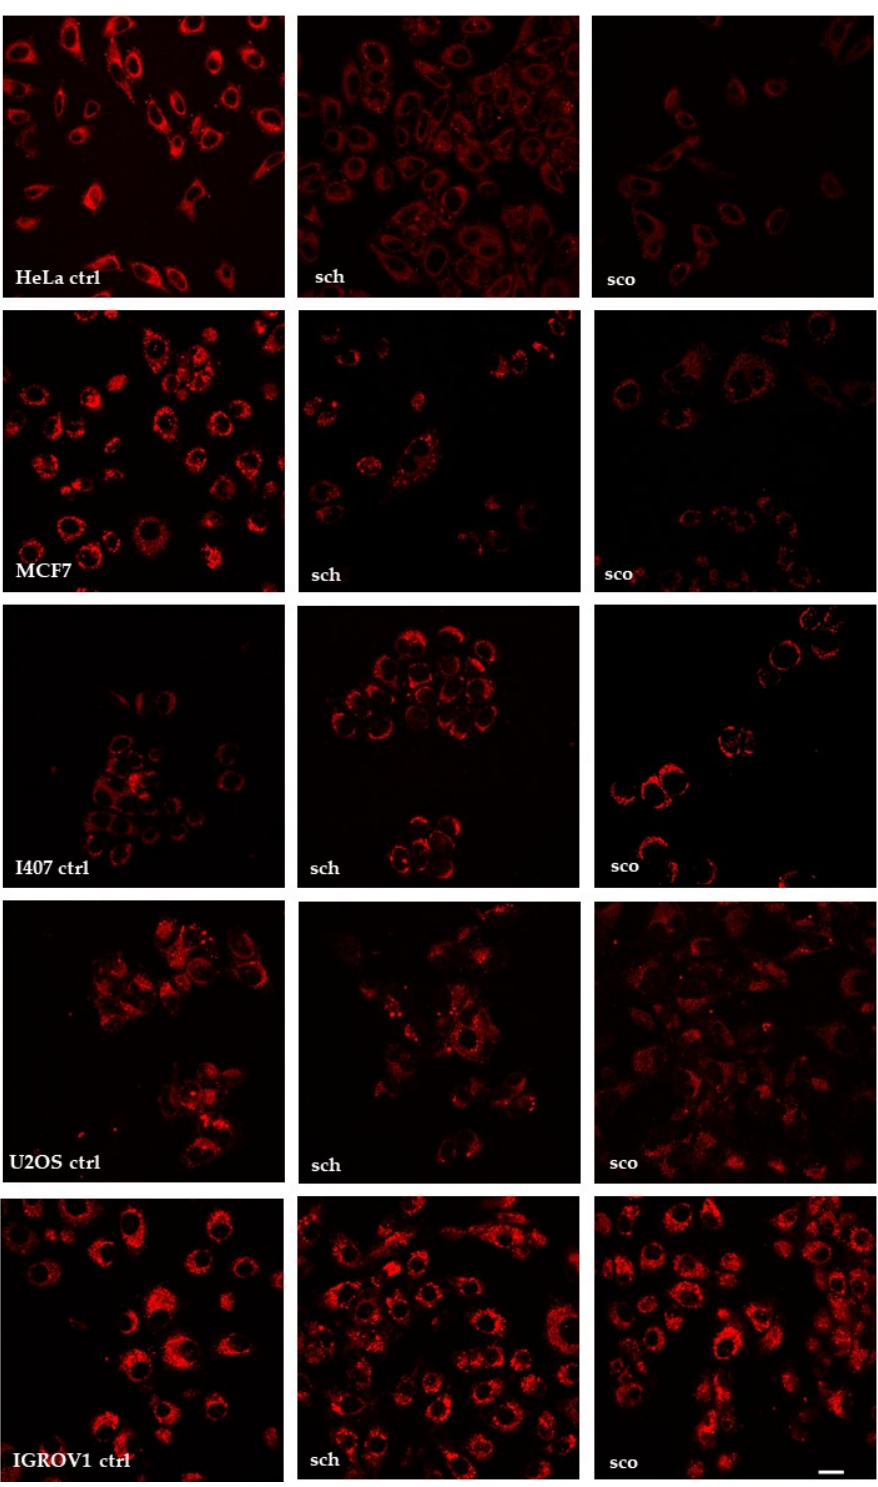
Figure 3. Confocal microscopy of cells after 1 h of treatment with SCH or SCO . Photographs were taken at 60× magnification, bar = 20 μ m.